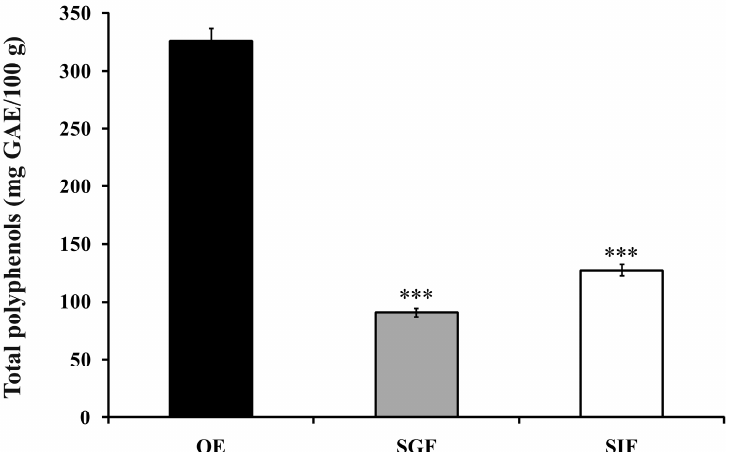
Figure 3. In vitro gastrointestinal release of polyphenols in simulated gastric fluid (SGF) and simulated intestinal fluid (SIF) after in vitro digestion of optimal encapsulate (OE) (*** p < 0.001; One way analysis of variance, compared to the control, OE). Results are expressed as mean ± SD of three independent experiments.